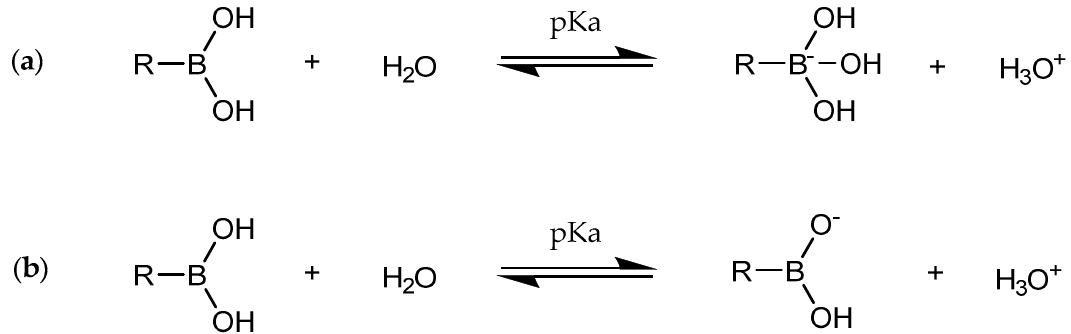
Figure 2. Ionization equilibrium of boronic acid in aqueous solutions. ( a ) Boronic acid as Lewis acid. ( b ) Boronic acid as Brønsted–Lowry acid.